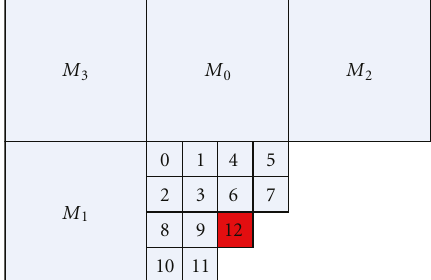
Figure 5: Candidate matches for a 4 × 4 luma block in the enhanced BMA intraprediction